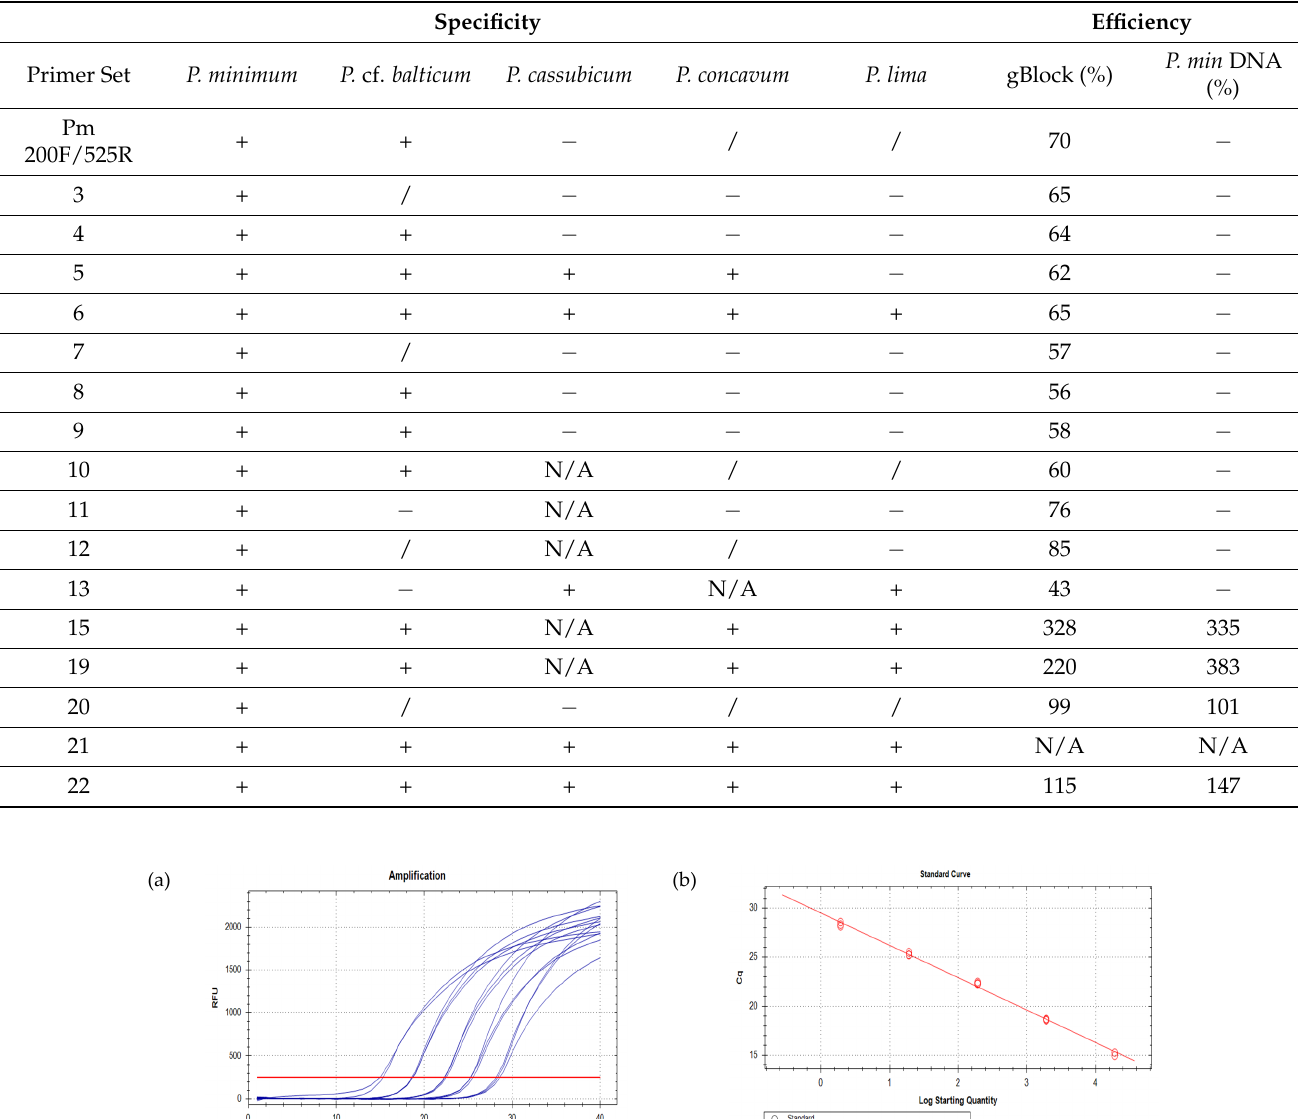
Table 5. Specificity and efficiency testing of each primer set including the previously published one [51]. (+) and ( − ) mean amplification or no amplification, respectively, and (/) denotes amplification at a high C q and/or was at or below the lowest dilution point on the P. minimum standard curves and/or was amplified but had a different melt peak. N/A means the primer set was not subjected to that test.